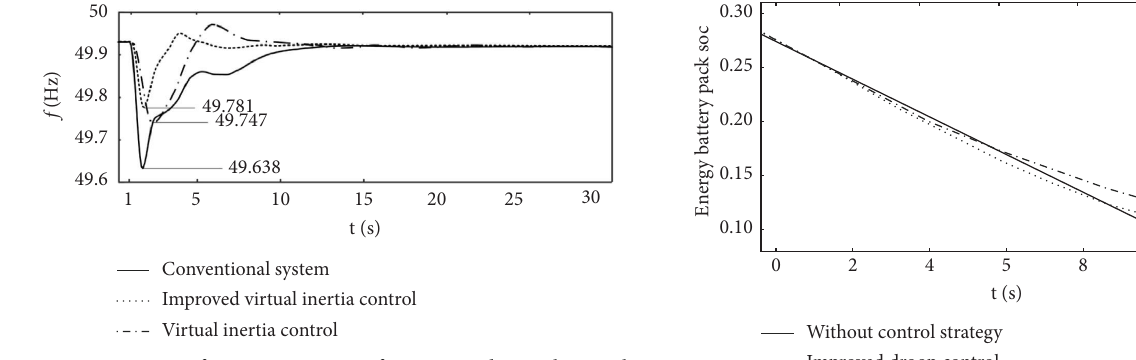
Figure 11: System frequency response for improved virtual inertial control.